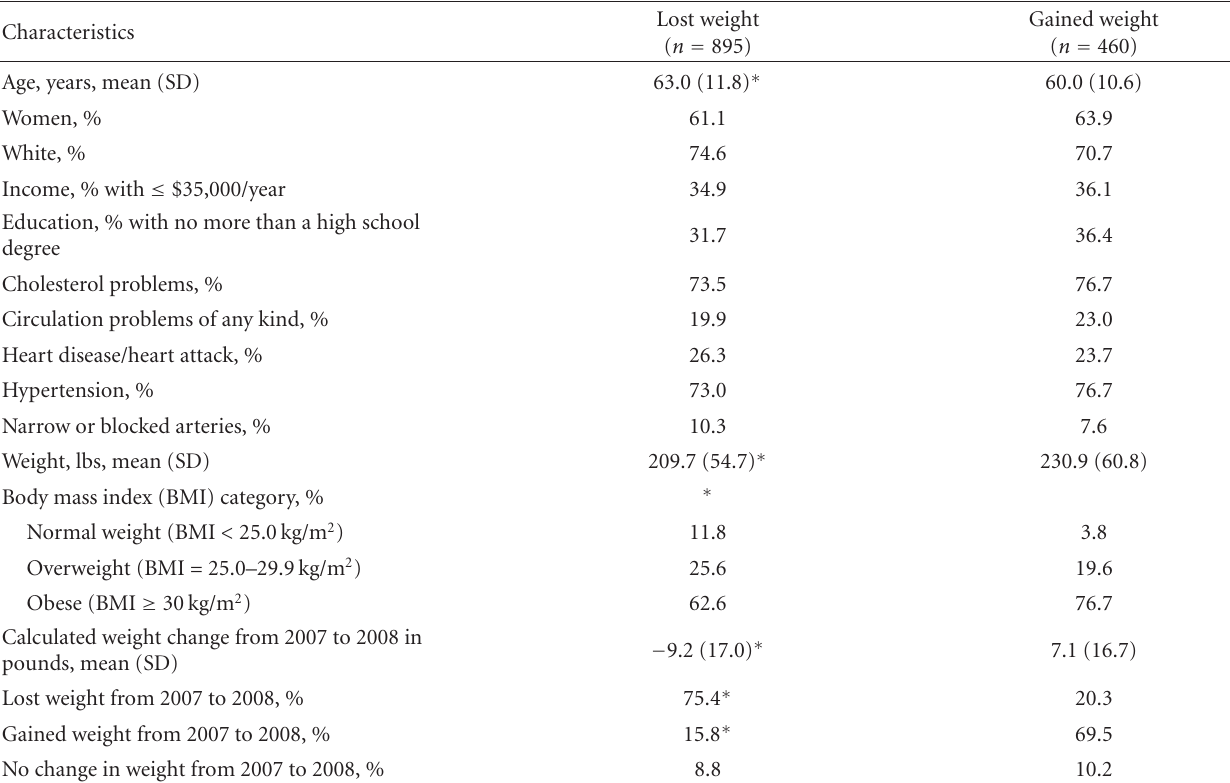
Table 1: Characteristics of SHIELD respondents with type 2 diabetes who reported gaining or losing weight in the past year.